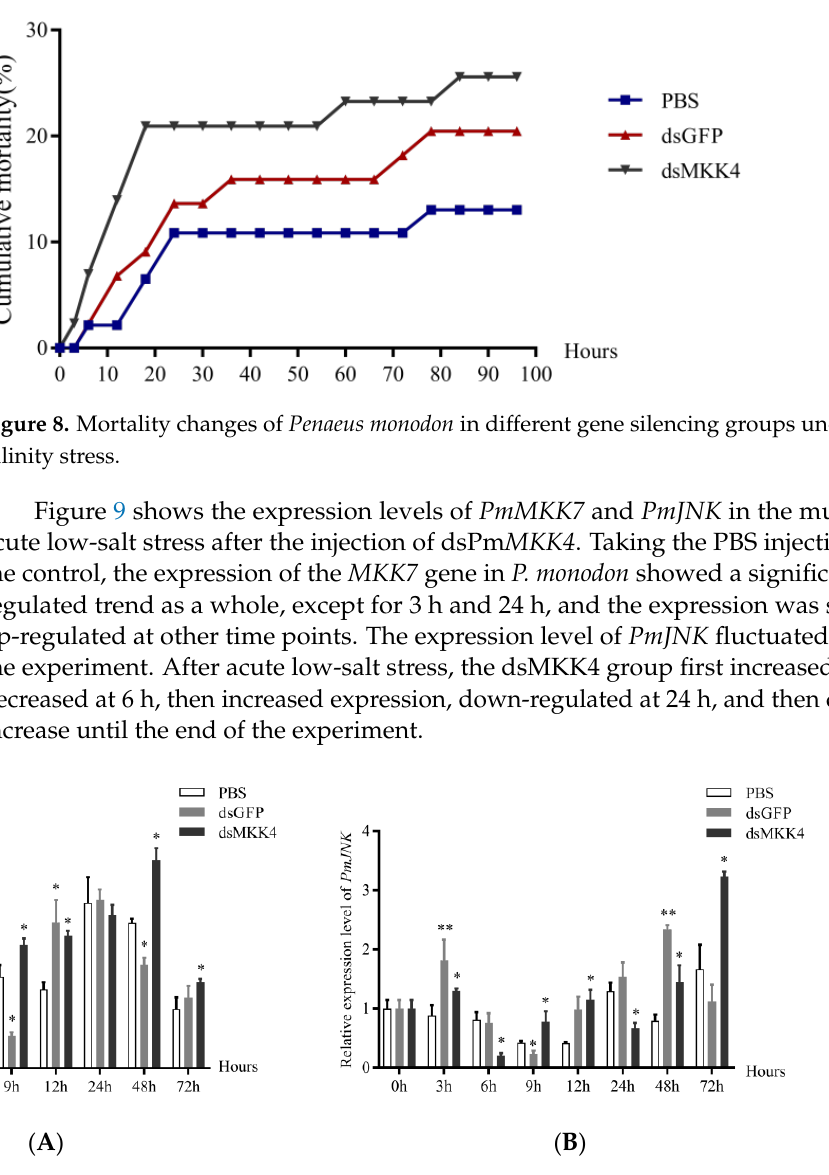
Figure 9. Relative expression levels of PmMKK7 ( A ) and PmJNK ( B ) after dsRNA- MKK4 under acute low salinity stress. * ( p < 0.05) , ** ( p < 0.01) . (Significant difference from the CG group).